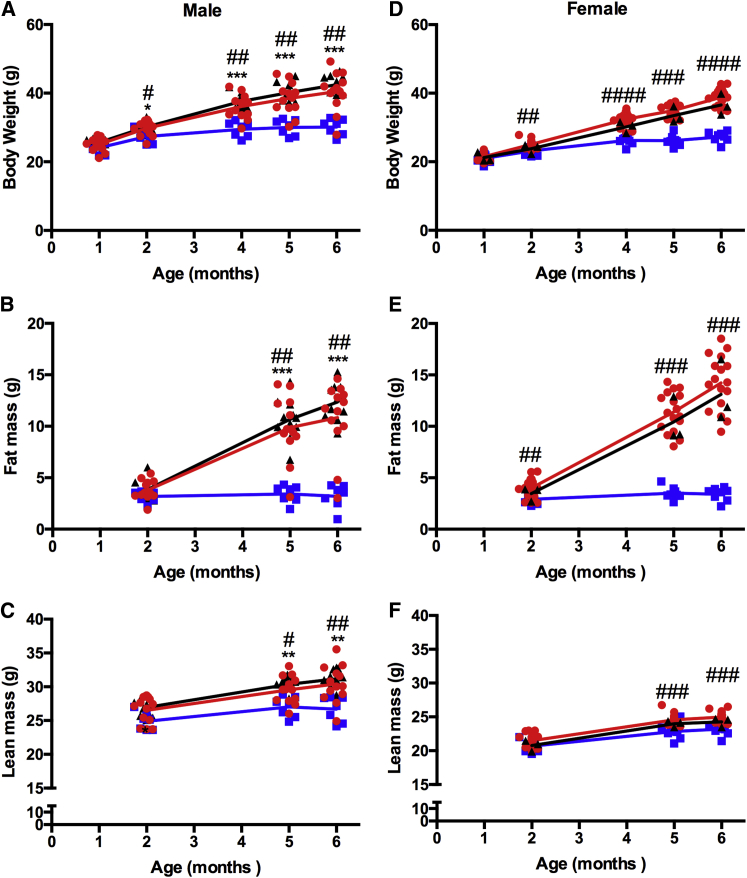
Wars2V117L/V117L Mice Have Reduced Body Weight due to Reduced AdiposityMale and female cohort 1 mice: (A and D) body weight, (B and E) fat mass, and (C and F) lean mass, respectively. Wars2V117L/V117L, Wars2V117L/+, and Wars2+/+ littermate numbers were 7 and 8, 13 and 17–21, and 11 and 3 male and female, respectively; mean ± SD. Areas under the curve (AUCs) were compared for males using an ordinary one-way ANOVA with Tukey’s multiple comparison test and for females using a one-way ANOVA non-parametric Kruskal-Wallis test and Dunn’s multiple comparison test. For AUC for Wars2+/+ and Wars2V117L/V117L, Wars2+/V117L and Wars2V117L/V117L, and Wars2+/+ and Wars2V117L/+, male body weight was p < 0.0001, p = 0.0002, and p > 0.5057; fat mass was p < 0.0001, p < 0.0001, and p = 0.6505; and lean mass was p = 0.0063, p = 0.0008, and p = 0.5314. Female body weight for Wars2+/V117L and Wars2V117L/V117L was p < 0.0001, fat mass was p = 0.0001, and lean mass was p = 0.0055 (wild-type [WT] comparisons not shown, because n = 3). Significance at specific time points was calculated with a one-way ANOVA non-parametric Kruskal-Wallis test and Dunn’s multiple comparison test. Significance between Wars2+/+ and Wars2V117L/V117L and between Wars2+/V117L and Wars2V117L/V117L is shown as ∗ and #p < 0.05, ∗∗ and ##p < 0.01, and ∗∗∗ and ###p < 0.001, respectively. Wars2V117L/V117L mice are blue squares, Wars2V117L/+ mice are red circles, and Wars2+/+ mice are black triangles. See also Figure S4.